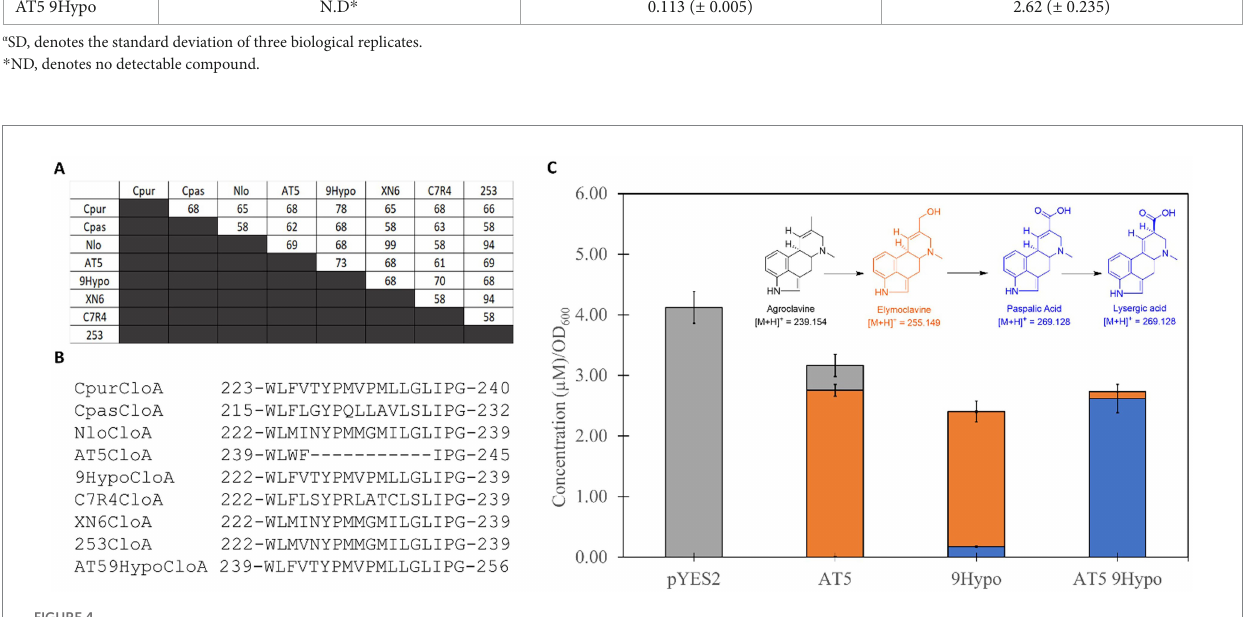
FIGURE 4 Sequence analysis of active CloA orthologs and sequence alignment. (A) Pairwise sequence alignment scores of active wildtype CloA sequences. (B) Multiple sequence alignment of active wildtype CloA sequences in the region of the missing sequence in AT5 cloA. Numbers represent the amino acid position in each wildtype orthologs. Sequence of the 9Hypo CloA orthologs was inserted into the region of AT5 CloA between the conserved residues WL and IPG. Numbers represent the amino acid position in each orthologs. (C) Screening of chimeric AT5 9Hypo CloA in Saccharomyces cerevisiae with agroclavine as a substrate. Error bars are representative of three biological